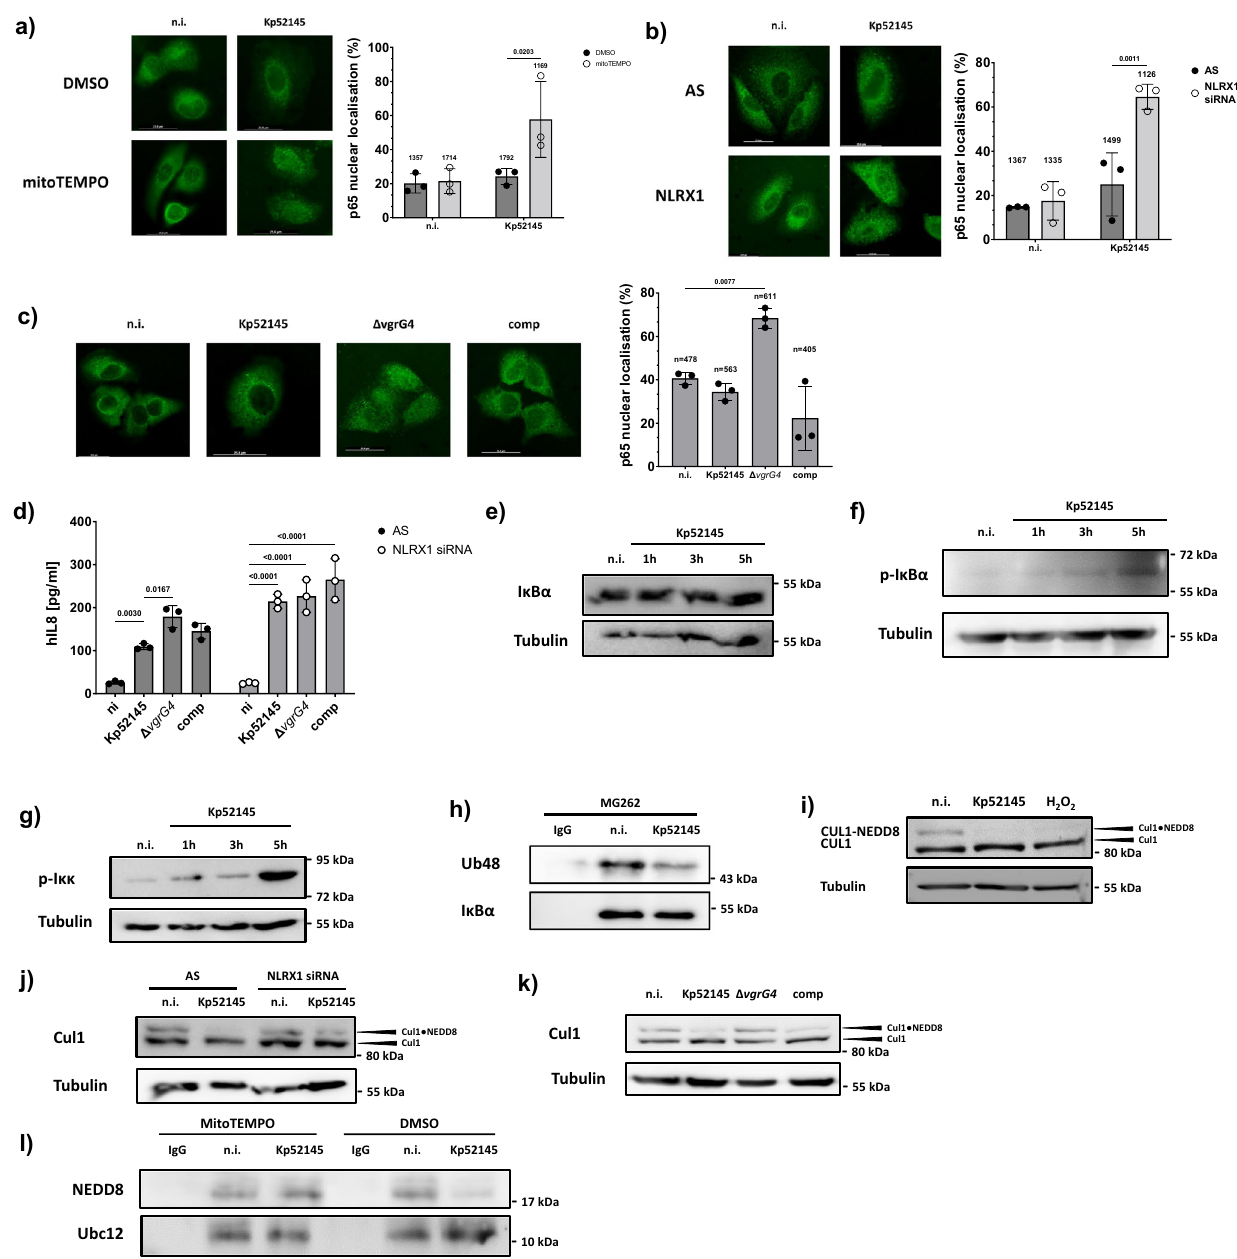
Fig. 6 | NLRX1-mediated ROS controls NF- κ B signalling and affects cullin 1 NEDDylation. Immuno fl uorescence microscopy of A549 cells stained with anti- bodyforthep65NF- κ Bsubunit.Cellswerepre-treatedwithmitoTEMPO(10 μ M,2h pre-infection),orwithvehiclecontrol(DMSO)andinfectedwithKp52145for3h( a ). b Cells were transfected with NLRX1 siRNA (50nM) or a non-silencing control (AS) and infected with Kp52145 for 3h. c Cells were infected with Kp52145, the vgrG4 mutant ( Δ vgrG4 ) or the complemented strain (comp, Δ vgrG4 /pBAD30 vgrG4 ) for 3h. The percentage of p65 NF- κ B localised in the nucleus is represented on the graphin a – c anditistheresultofcountingofminimumofhundredcellsfromeach of three independent experiments. The total number of counted cells is indicated on top of each bar. ELISA of IL-8 secreted by A549 cells transfected with either NLRX1 siRNA (50nM) or a non-silencing control (AS) and infected with K. pneu- moniae strains. After 3h of contact, the medium was replaced with medium con- taining gentamicin (100 µ g/mL) to kill extracellular bacteria, and after 2h the medium was collected ( d ). Images are representative of three independent experiments. Data in graphs are presented as the mean±SD of three independent experiments. Two way-ANOVA with Holm-Sidak ’ s multiple comparisons test was used for statistical signi fi cance ( p values indicated in the graph). e Immunoblot analysis of total I κ B α and tubulin levels in lysates of A549 cells infected with